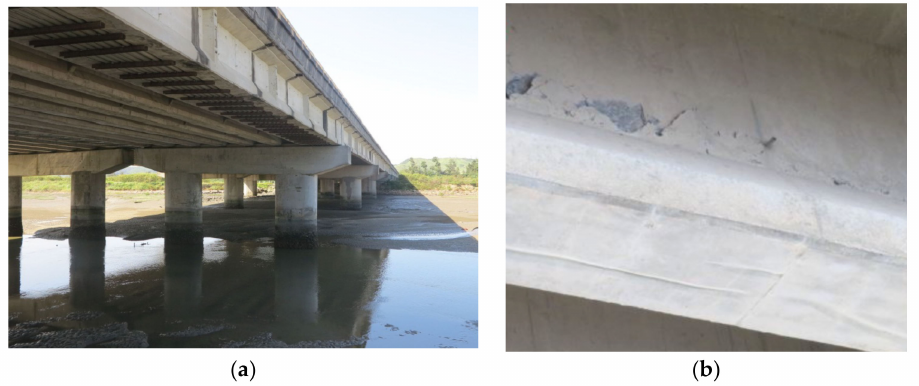
Figure 1. Photograph of the investigated bridge: ( a ) side view; ( b ) cracks along the tendon